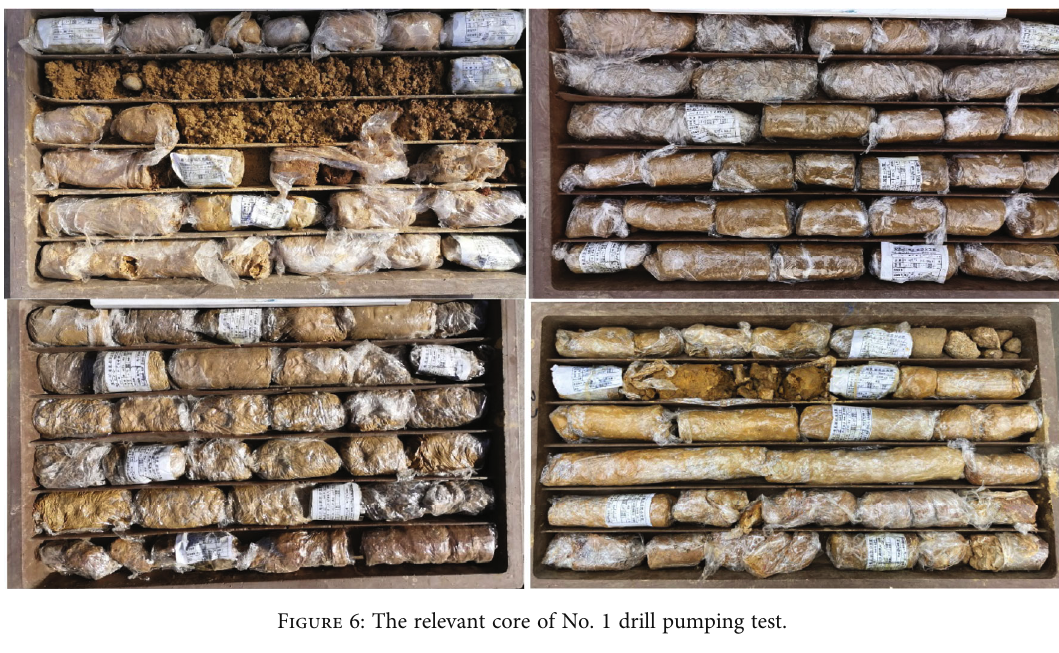
Figure 6: The relevant core of No. 1 drill pumping test.